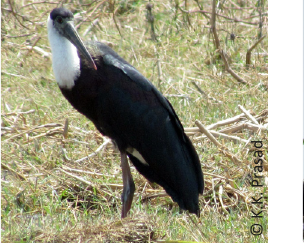
Image 10. Oriental White Ibis Threskiornis melanocephalus